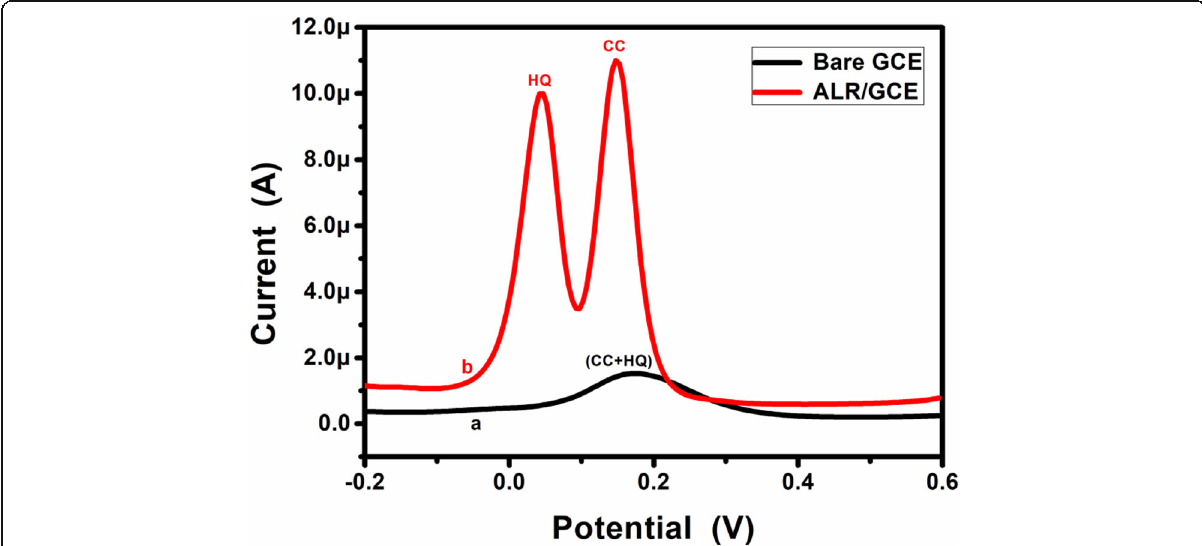
GCE (curve b) with 0.2 M buffer of pH 7.4